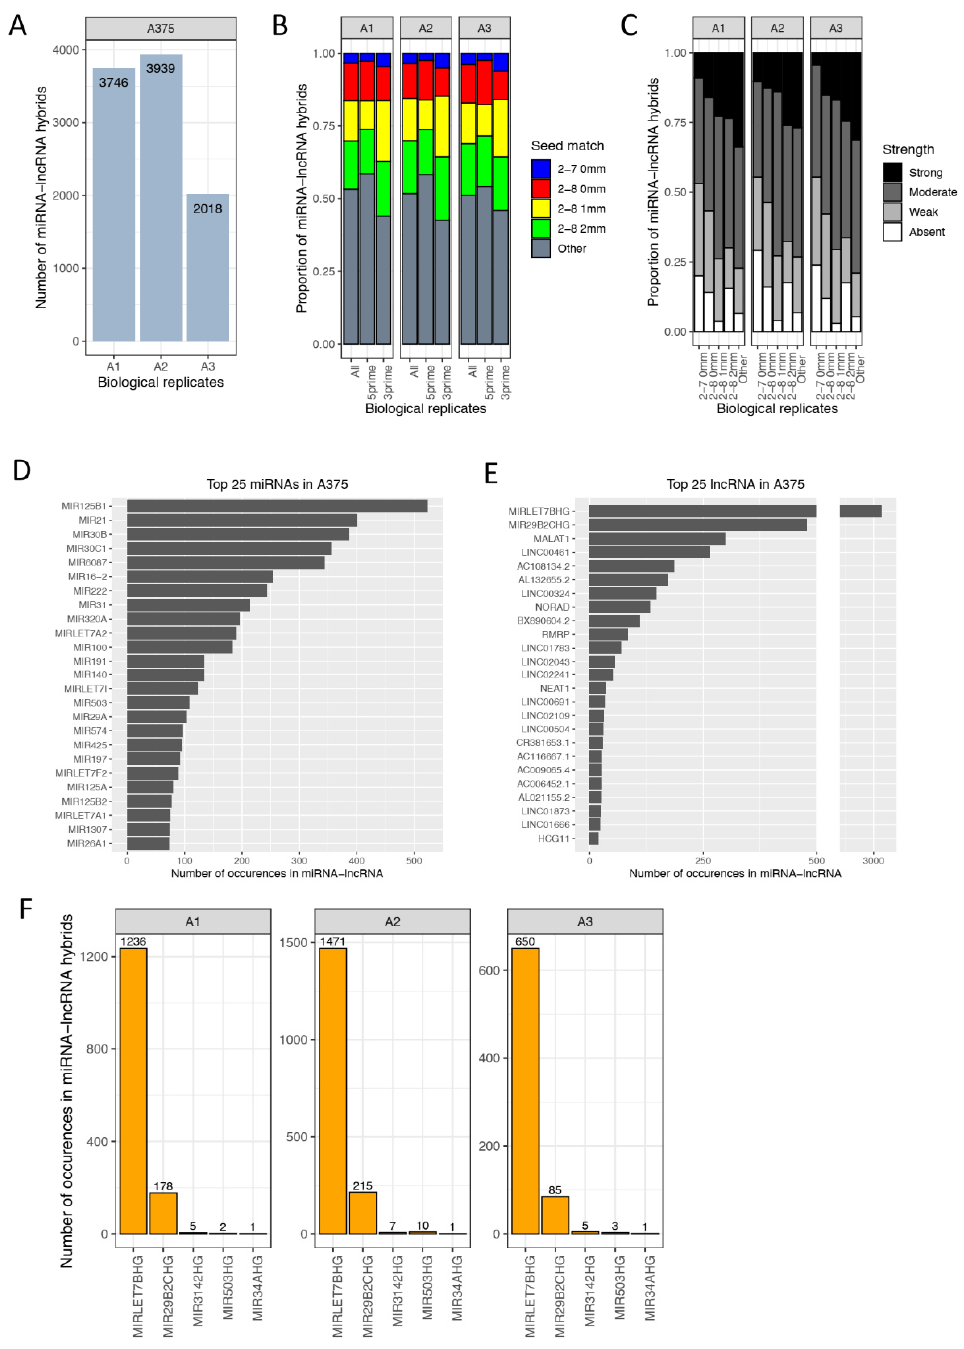
Figure 10. miRNA-lncRNA hybrids. ( A ) Number of miRNA-lncRNA hybrids in A375 replicates. ( B ) The type of seed pairing (5 (cid:48) miRNA sequence) was divided and plotted as described in Figure 2E. The predicted and canonical seed sequence was displayed in blue (2–7 nt no mismatches) and red (2-nt no mismatches). Non-canonical seed pairing was displayed in yellow and green (one or two mismatches within the seed) or in grey for additional types of seed pairing (Other). ( C ) miRNA base-pairing via the 3 (cid:48) portion of the miRNA (supplementary 3 (cid:48) or non-seed pairing) as described in Figure 2F. The “strength” of binding outside the seed region at the 3 (cid:48) end of the miRNA based on number of bound nt: >8 nt (strong), 5–8 nt (moderate), 1–4 nt (weak), and 0 nt (absent). Top 25 ( D ) miRNAs and ( E ) lncRNAs that occur in miRNA-lncRNA hybrids showing the number of hybrid sequences each RNA species occurs in. ( F ) Number of occurrences of pri-miRNA genes, which were labelled as lncRNAs in miRNA-lncRNA hybrids across three biological A375 replicates (A1, A2,